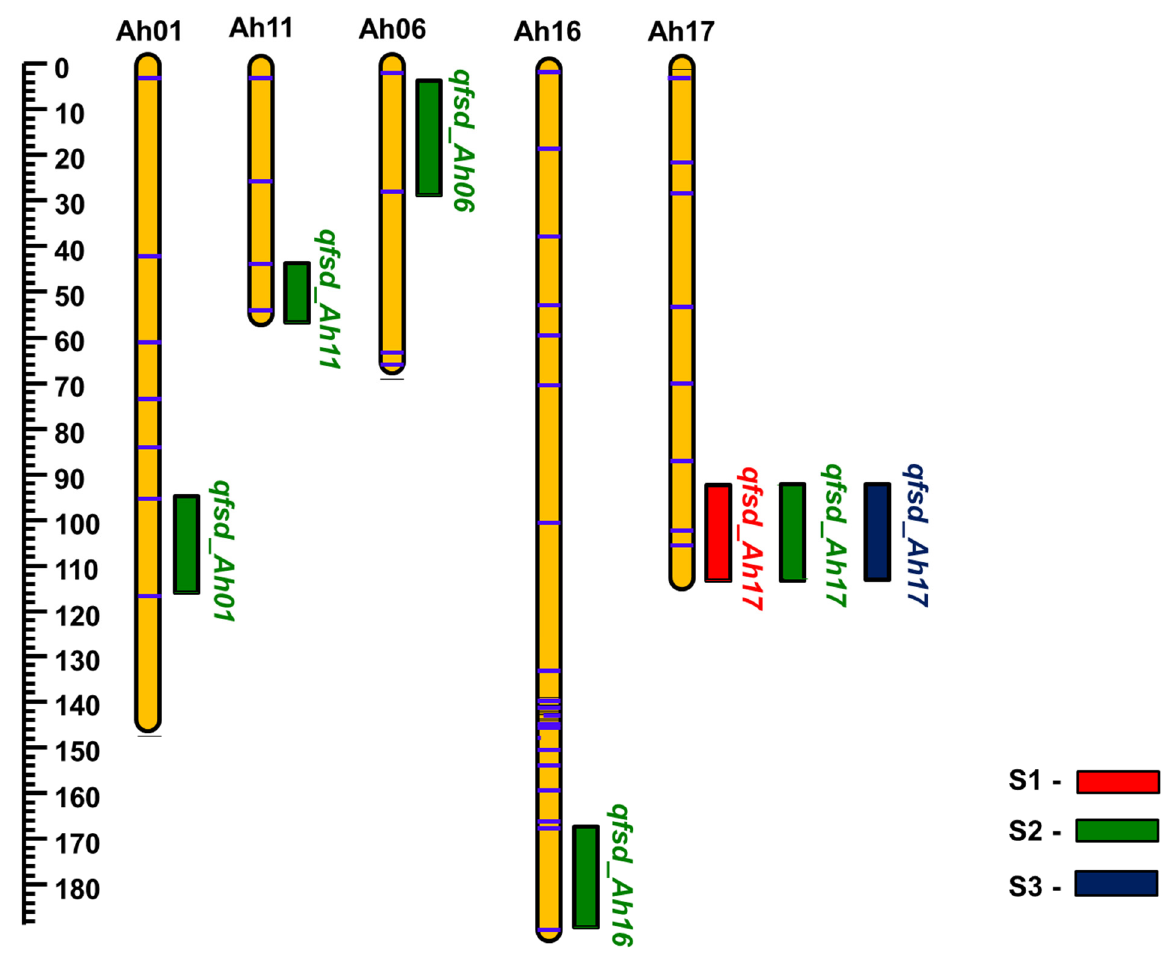
Figure 3. Major QTLs associated with fresh seed dormancy.